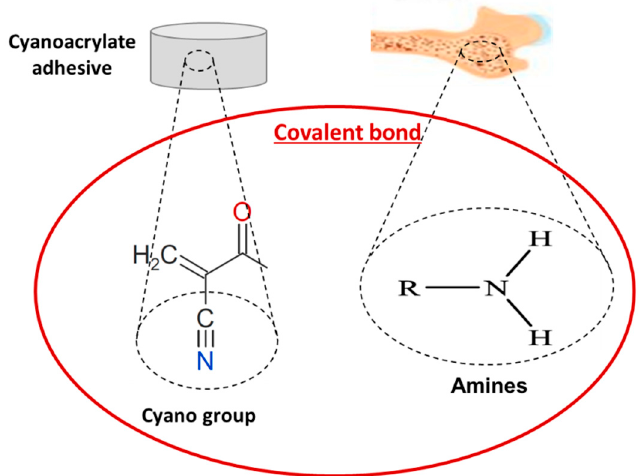
Figure 6. Covalent bond between cyano groups of the adhesive system (cyanoacrylate-based) with amines present in bone collagen matrix.